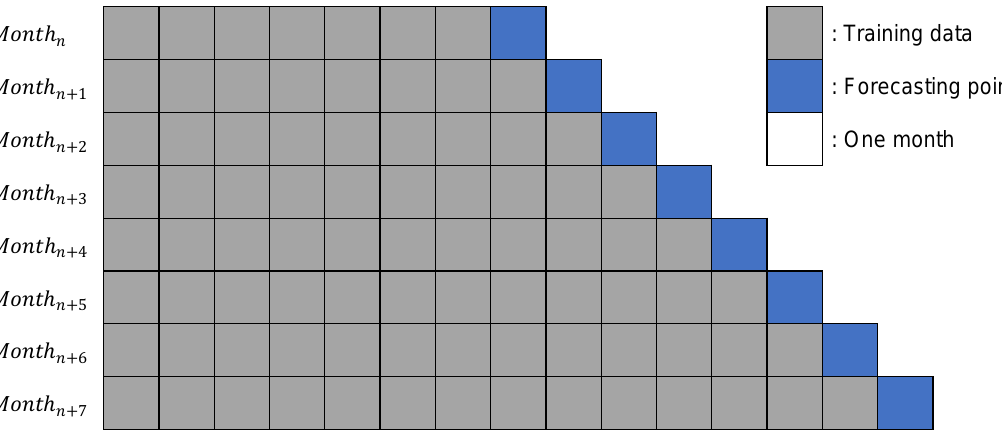
Figure 4. Example of monthly time-series cross-validation.